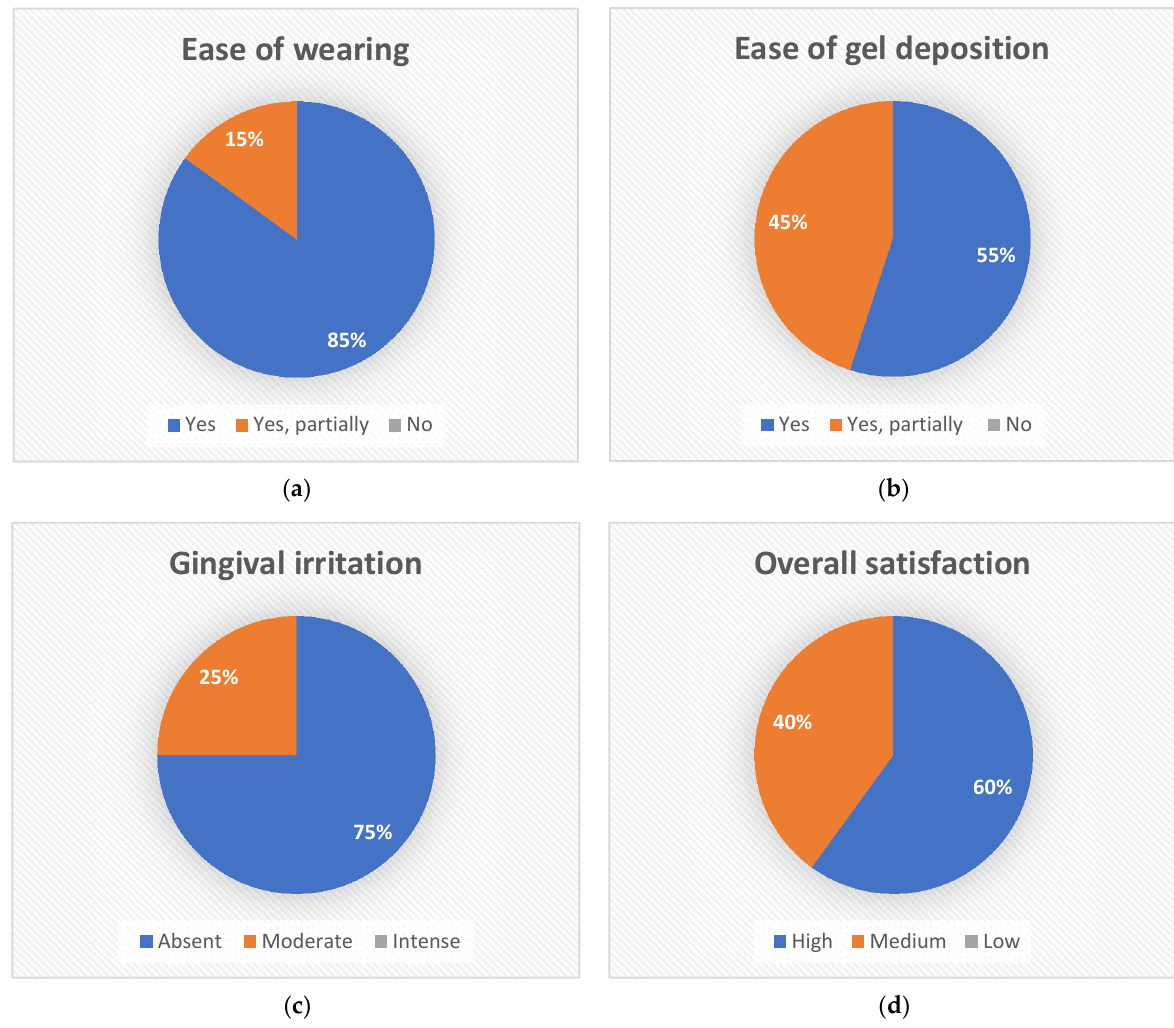
Figure 5. Results of the evaluation of the tray and of the whitening treatment: ease of wearing ( a ), ease of gel deposition ( b ), gingival irritation ( c ), and overall level of satisfaction ( d ).